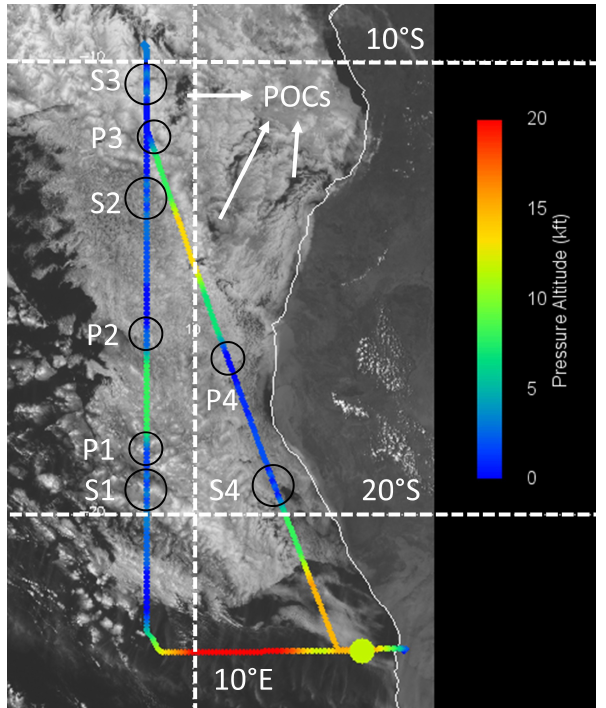
Figure 1. Visible image from the Spinning Enhanced Visible and Infrared Imager at 14:00UTC on 6 September 2016 (PRF5), over- laid by the PRF5 flight track and colored by flight altitude. Circles indicate sawtooth maneuver (S) and individual cloud profile (P) locations (https://bocachica.arc.nasa.gov/ORACLES/, last access: 22 March